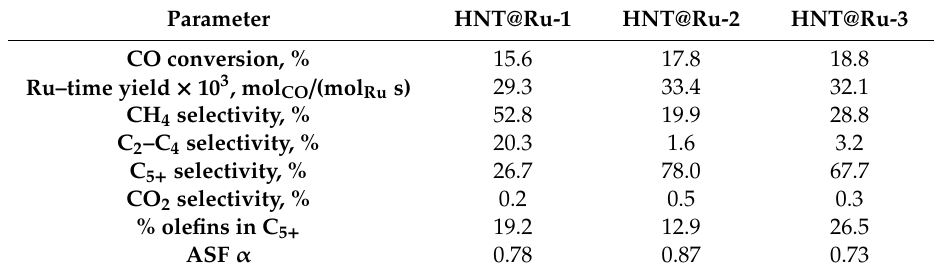
Table 2. Ru-loaded halloysite catalyst performance in Fischer–Tropsch synthesis 1 . Parameter HNT@Ru-1 HNT@Ru-2 HNT@Ru-3 CO conversion,